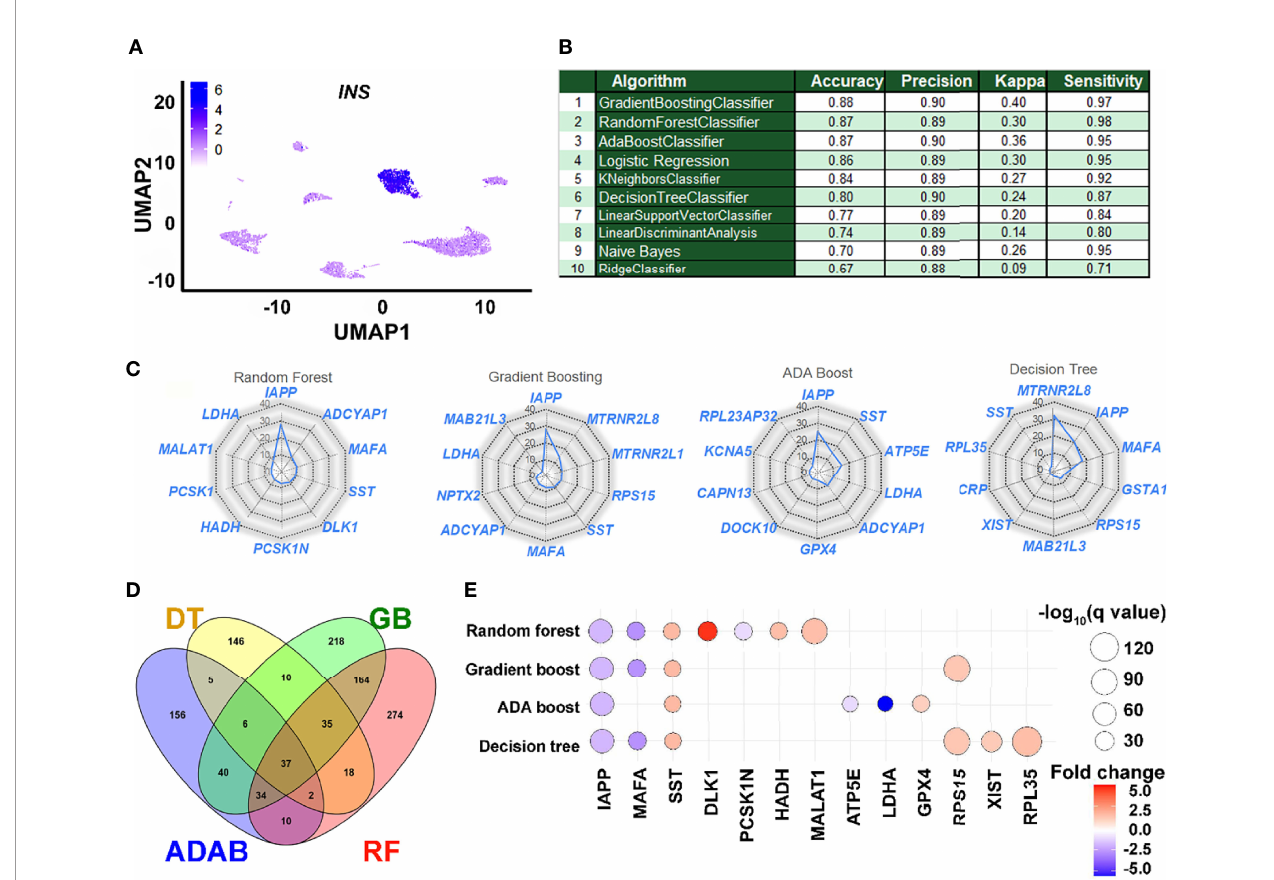
FIGURE 2 | Performance and application of learned features in understanding insulin gene transcription. (A) A 2D clustering of pancreatic single cells assessed in this study using UMAP (Uniform Manifold Approximation and Projection plot). Cellular subtypes based on the UMAP clustering algorithm are labeled and graded (scale, inset) as per the level of insulin gene transcripts. (B) The performance of learning models on accurately identifying insulin-positive (1) and insulin-negative (0) single cells from the validation dataset are presented. (C) Relative weighted rank contributions of the top 10 genes in each of the four listed ML algorithms are presented as spider plots plotted in the order of importance (starting clockwise at 12-O ’ clock position). Percent representation of each of the genes indicates their relative contribution in the set on the spider plot with a logarithmic scale (center=1% and outer circle=100%). A comparison of the gene features identi fi ed by the top three ensemble work fl ows is presented along with those identi fi ed by the Decision Tree classi fi er. (D) Pathways targeted by up to the top 100 features ( Supplementary Table 2 ) from each of the four selected ML methods (RF, Random Forest; GB, Gradient Boosting; ADAB, ADA Boost; DT, Decision Tree) identi fi ed using gene ontology (GO) function analysis are presented in the Venn diagram. Number of GO terms enriched and common for top features (genes) in each ML method are plotted. (E) All signi fi cantly dysregulated genes identi fi ed from and common to the four ML algorithms (C) presented herein were assessed in the scRNA- seq dataset from Ire1 a b -/- mice. Bubble plot presenting fold-change and statistical signi fi cance (q-value) for each of the genes in Ire1 a fl / fl and Ire1 a b – / – mice are shown. Blue color represents downregulation while red color indicates increased abundance of transcripts in Ire1 a b -/- mice compared to